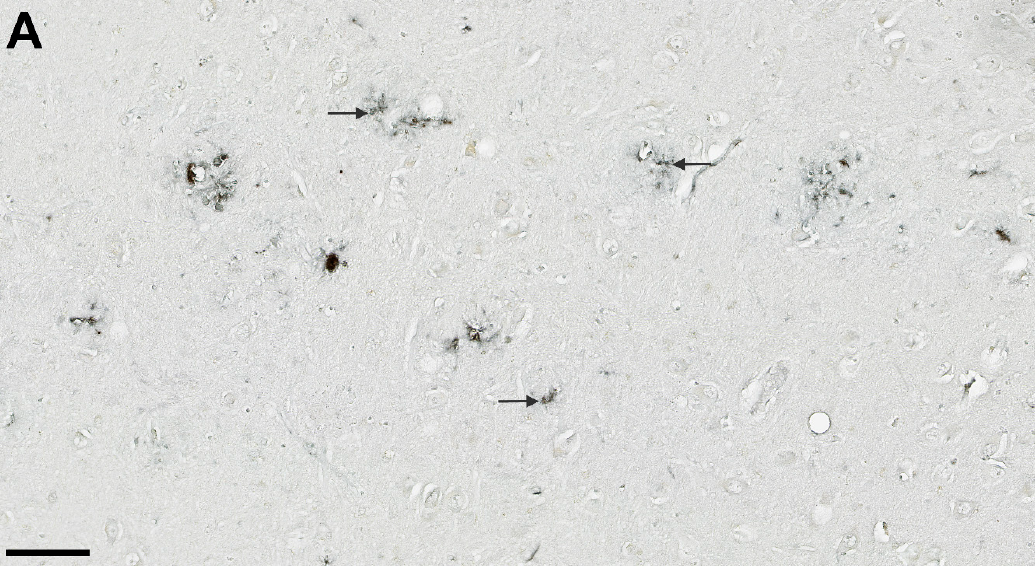
Figure 5. Expression of IBA1 marker in ramified microglia (arrows) in the CA1 in AD (case AD5). Scale bar 50 μ m.